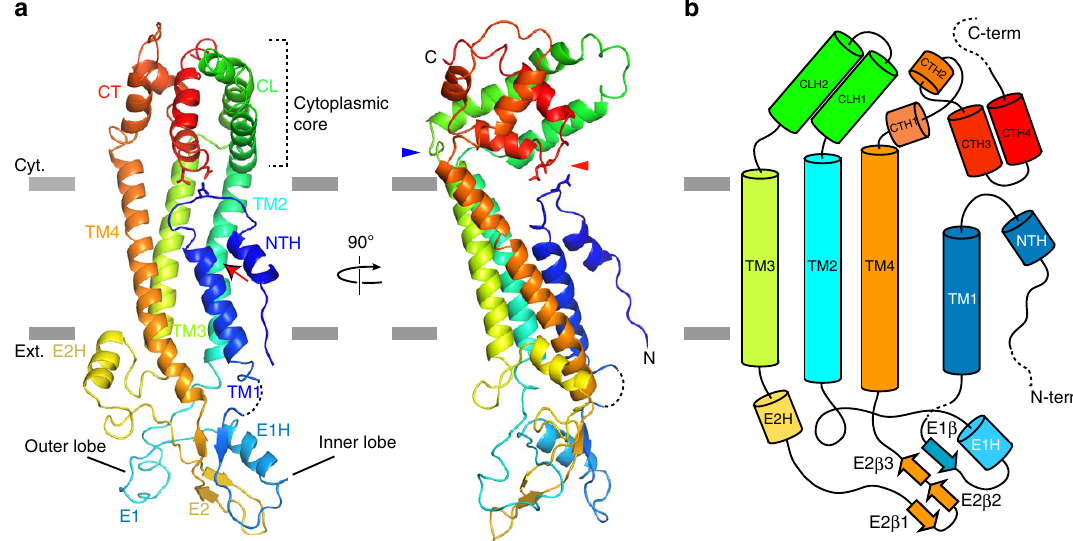
Figure 2 | Monomeric structure of INX-6. ( a ) Ribbon representation of the INX-6 monomeric structure. TM2 is kinked at P122 (red arrow). The cytoplasmic core is connected to TM2, TM3 and TM4 with kinked loops (blue arrowhead). The N-terminal loop interacts with CT (red arrowhead) via D25, L347 and N348 depicted in stick style. Grey lines indicate the estimated lipid bilayer borders. ( b ) Schematic representation of secondary structure of INX-6. Dashed lines indicate unassigned residues due to disorder. with a 30-Å diameter (Fig. 4b—cytoplasmic). The inter-subunit Lys183-Asp351 (Fig. 4c), resulting in a roof made of conse- interfaces are reinforced by the polar interactions of Arg168- cutively placed cytoplasmic cores. The spacing between adjacent Asp153, Asp175-Tyr356, Arg178-Thr318, Lys182-Ser317 and transmembrane helix bundles is rather curious (Fig. 4d and